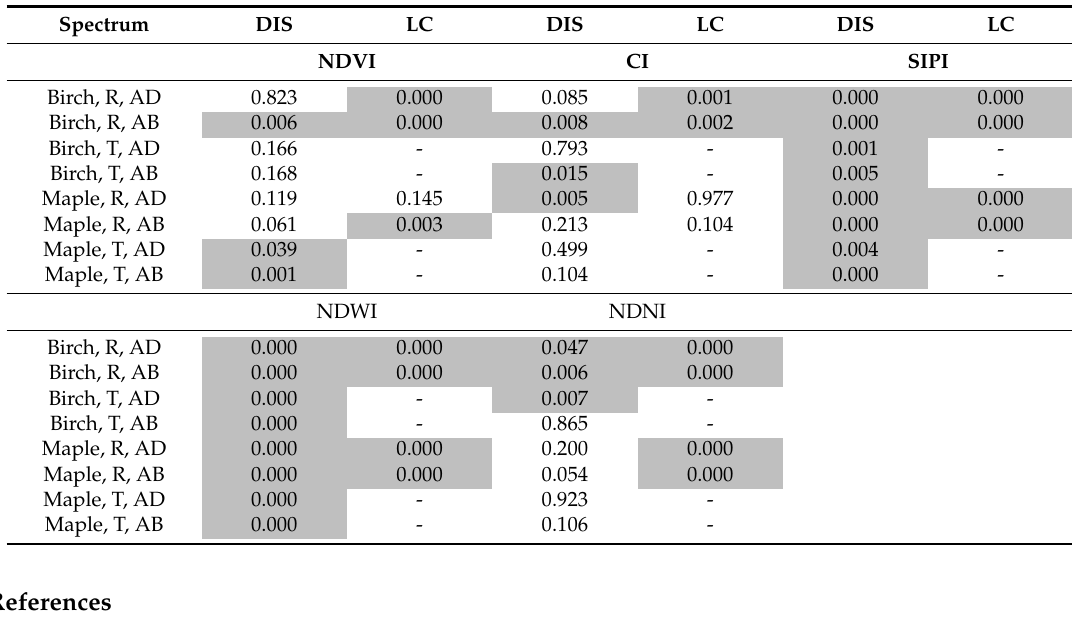
Table B3. Statistical differences in spectral indices calculated with different methods. The values shown are p -values in a t -test comparing double integrating sphere (DIS) or leaf clip (LC) to single integrating sphere. Statistically significant values ( p < 0.05) are highlighted. R = reflectance, T = transmittance, AD = adaxial side, AB = abaxial